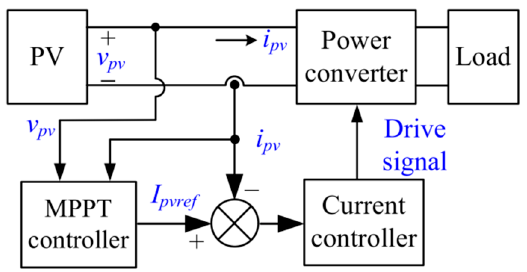
Figure 3. Schematic diagram of maximum power point tracking (MPPT) control for photovoltaic (PV) panels.